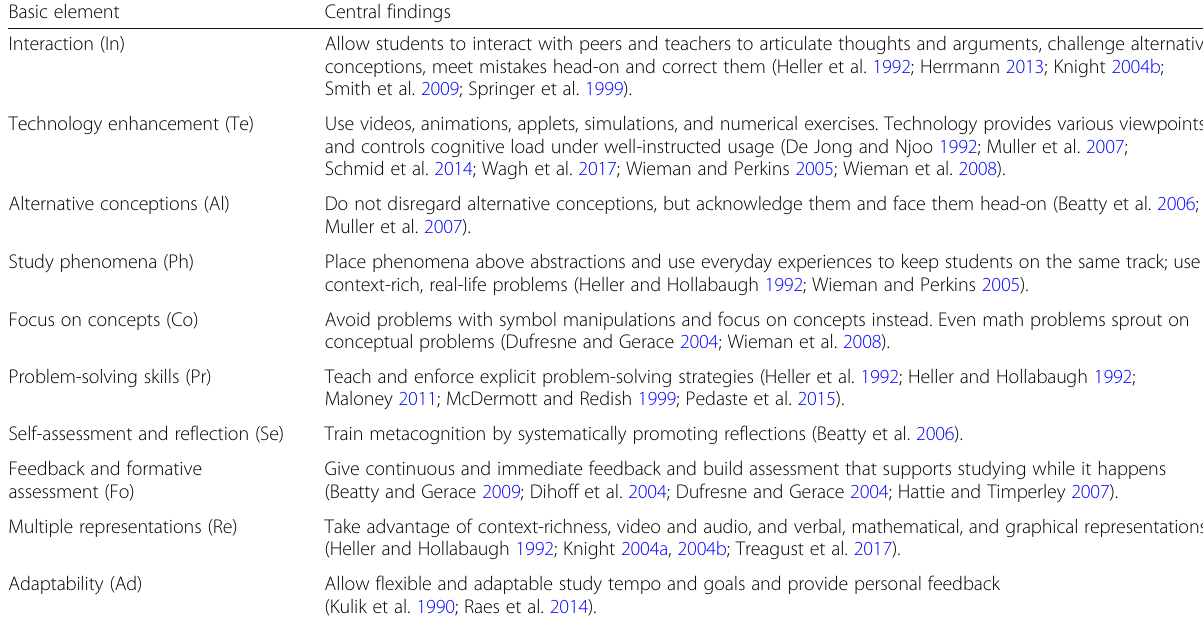
Table 1 The basic elements of active learning and examples for related attitudes and realizations Basic element Central